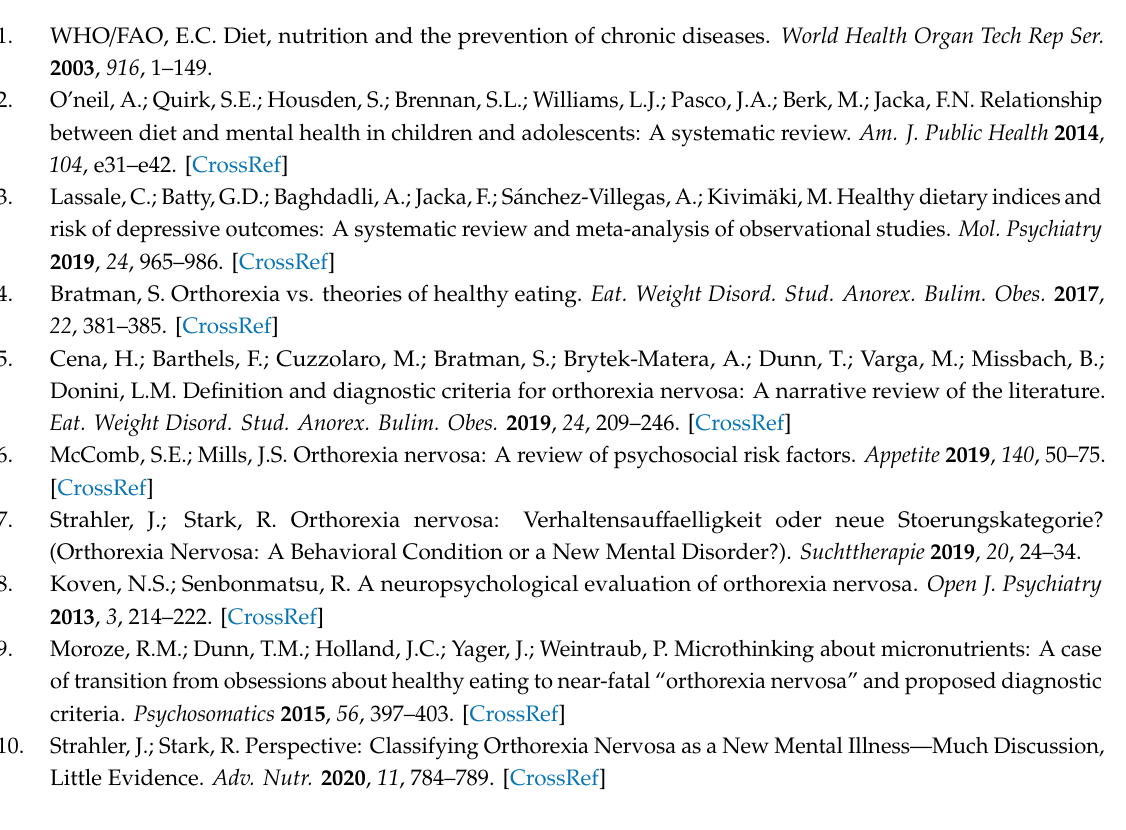
Table S1: Multiple regression analyses predicting wellbeing, life satisfaction and stress by healthy orthorexia (TOS-HeOr) and orthorexia nervosa (TOS-OrNe), Table S2: Multiple regression analyses predicting anxiety, depression and stress by healthy orthorexia (TOS-HeOr) and orthorexia nervosa